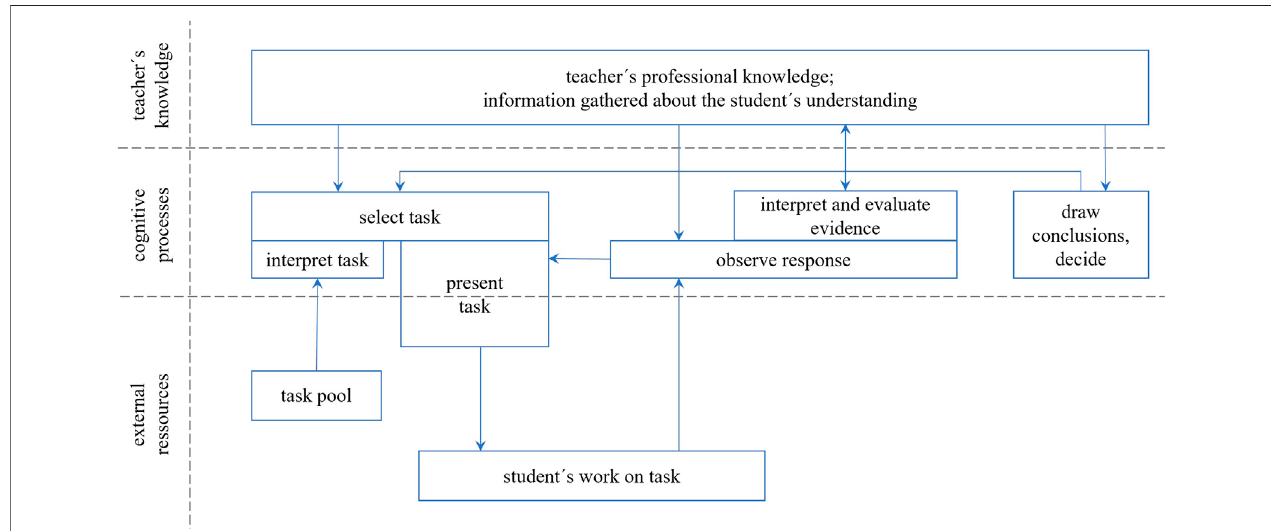
FIGURE 1 | Model of task-based diagnostic